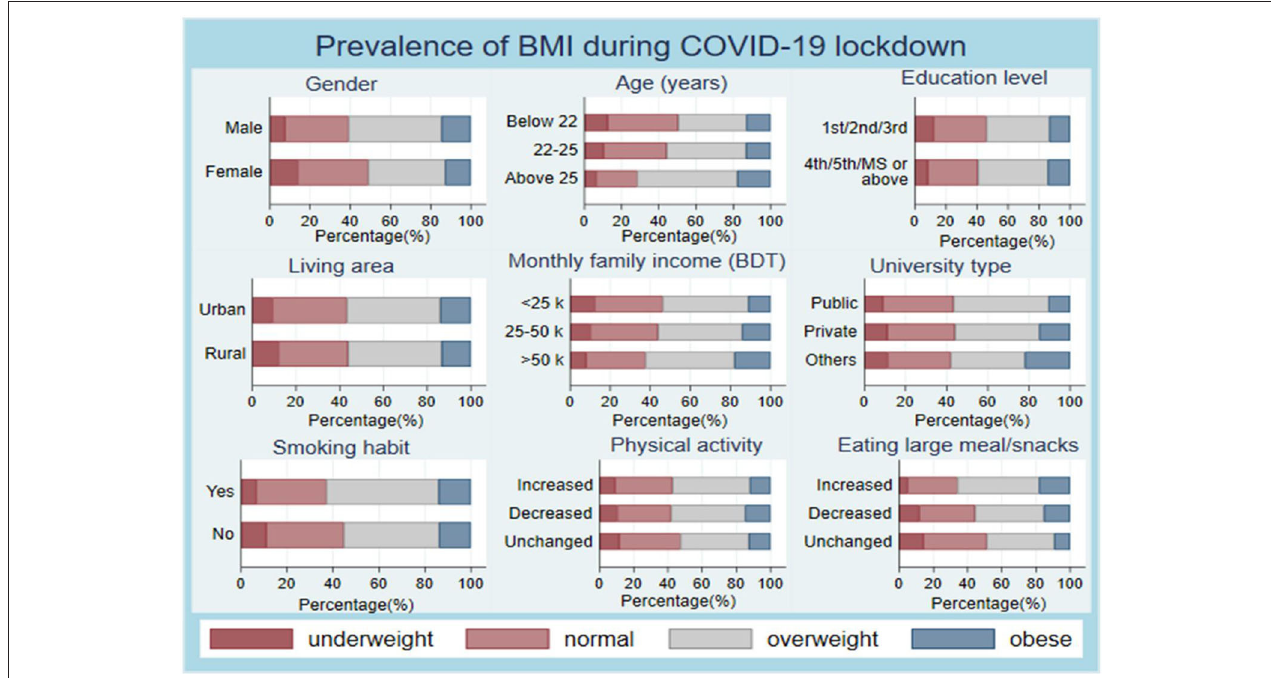
FIGURE 2 | The prevalence of BMI among several sociodemographic groups of university students in Bangladesh during the prolonged COVID-19